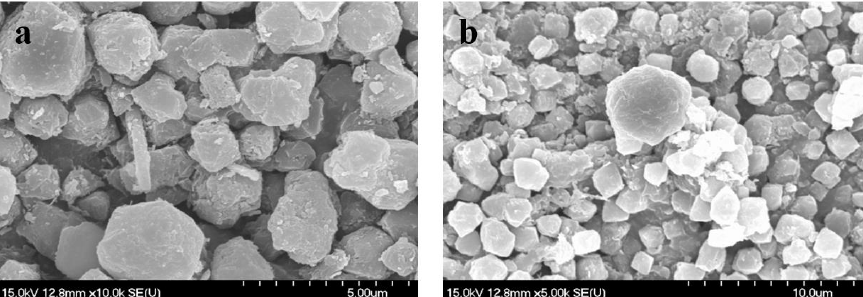
Figure 1. SEM images of: ( a ) CaX and ( b ) IL/CaX catalysts.